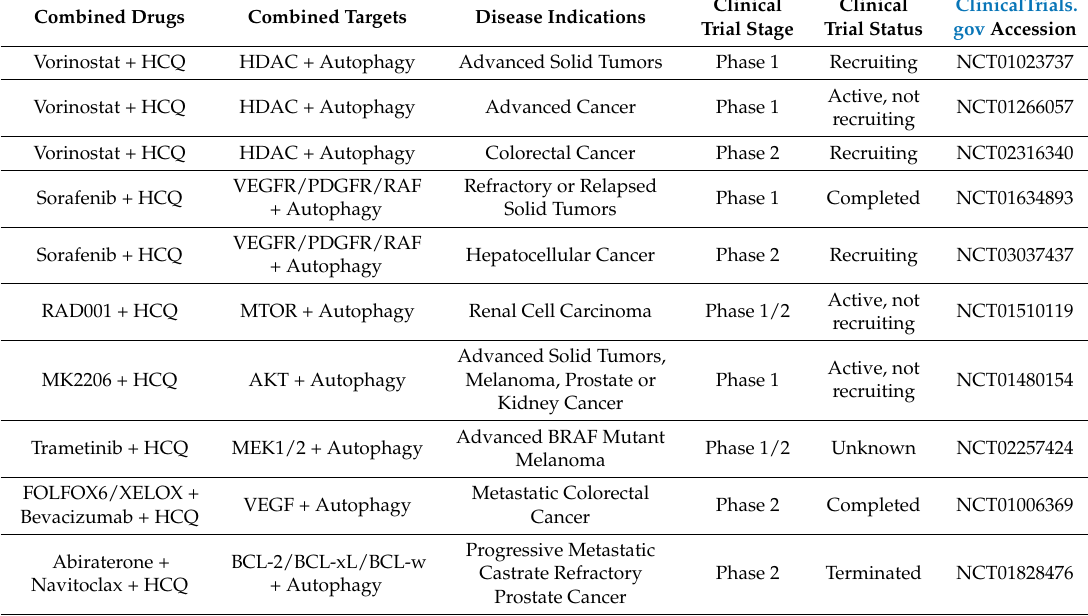
Table 2. Clinical trials of combination of autophagy inhibitors and other targeted therapeutics. (Data from ClinicalTrials.gov